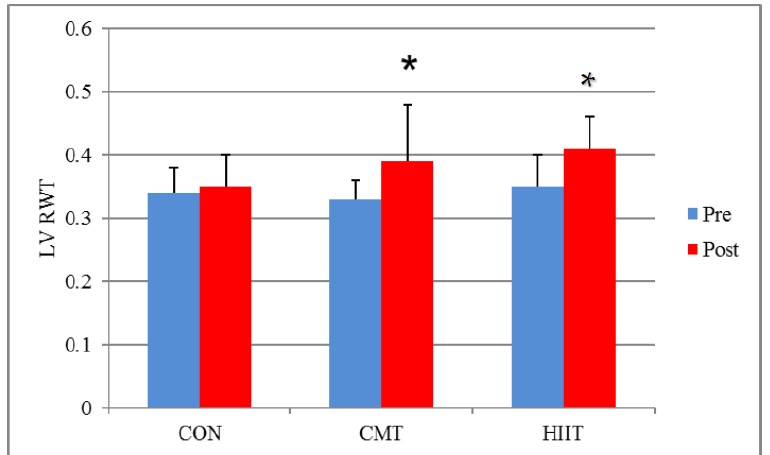
Figure 6. Mean LV RWT Changes before and after 12 Weeks of CMT and HIIT; * Indicates a significant increase compared with the control group ( p < 0.05). LV RWT: Left Ventricle Relative Wall Thickness. CON: Control. CMT: Continuous Moderate Training. HIIT: High-Intensity Interval